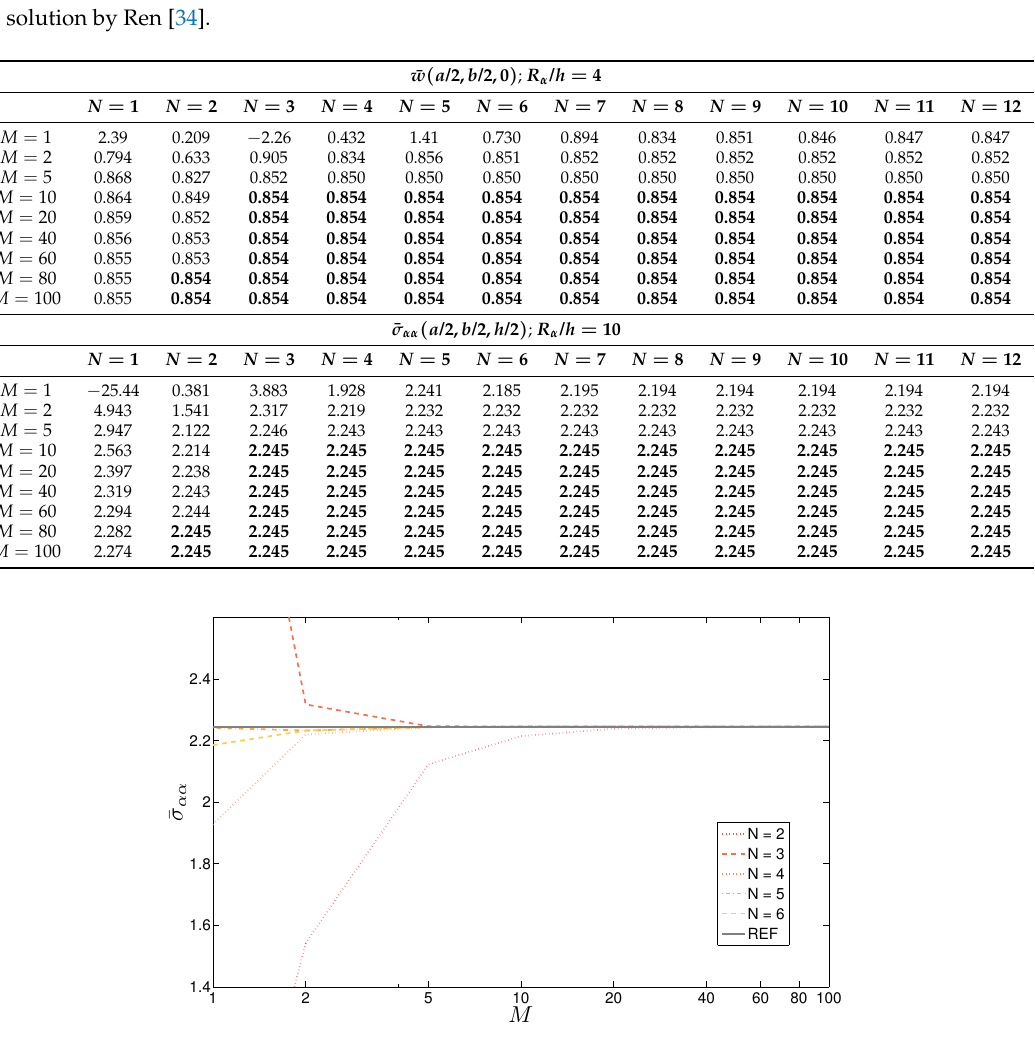
Figure 5. Case 2, simply supported composite laminated cylindrical shell with thickness ratio R α / h = 10. Stress ¯ σ αα vs. number M of mathematical layers introduced for different orders of expansion N for the exponential matrix. REF means 3D solution by Ren